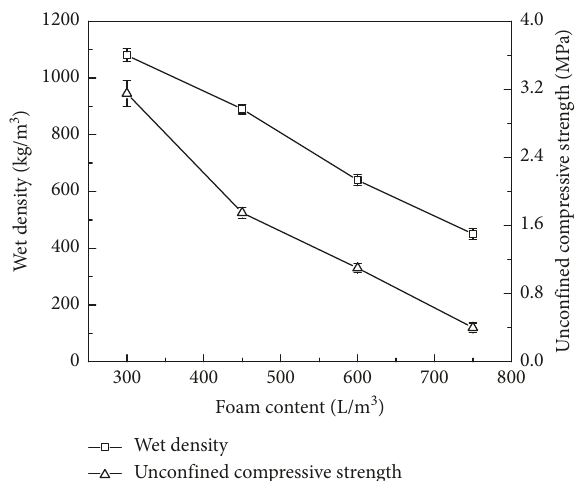
Figure 6: Influence of the foam content on the wet density and compressive strength of FMLSB.